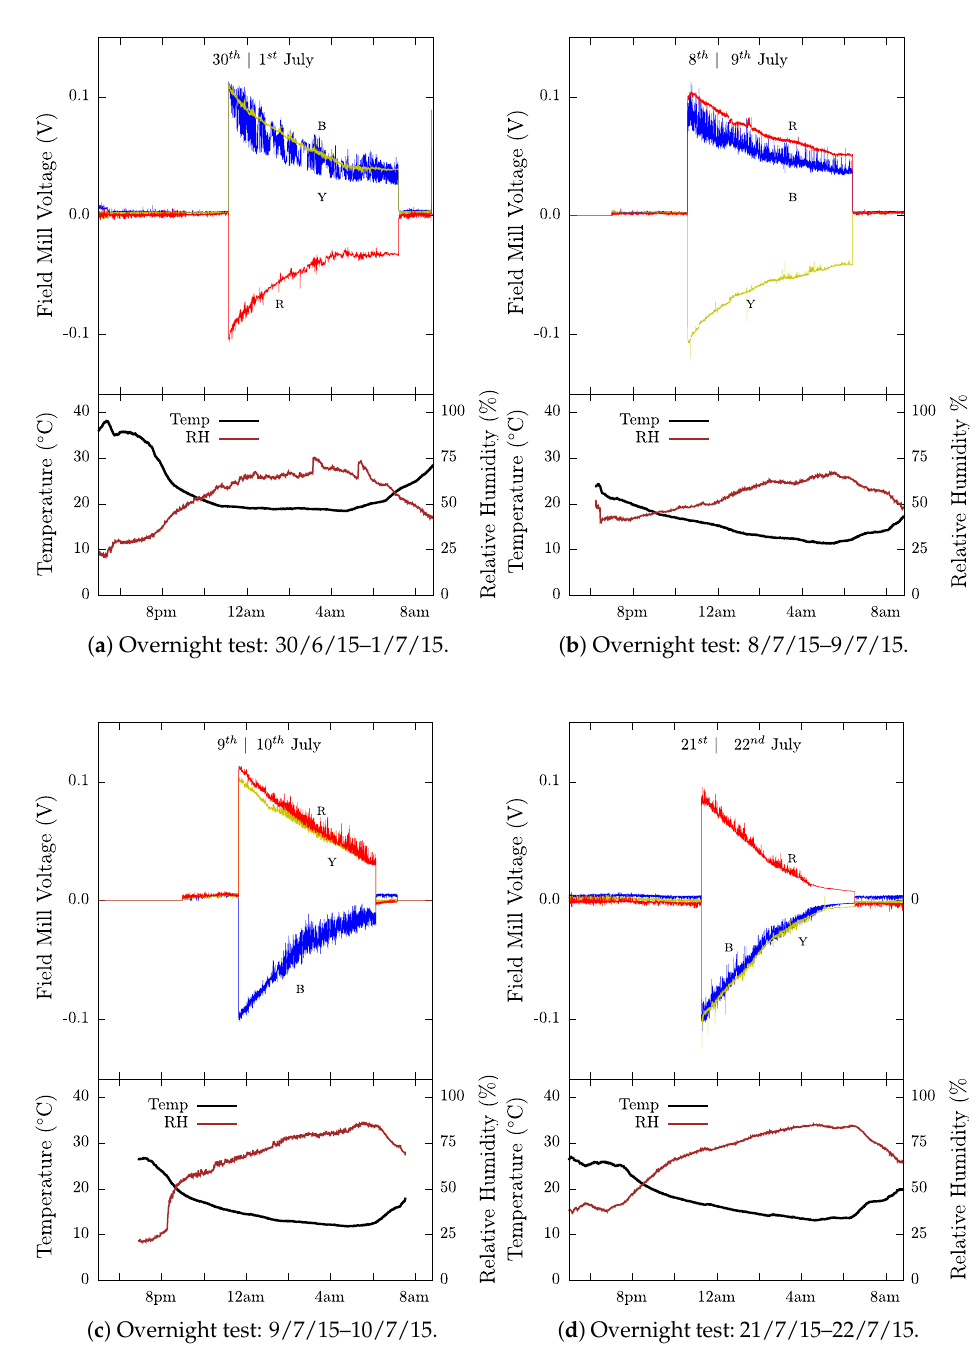
Figure 7. Recorded Field Mill voltages for each phase (R = Red, Y = Yellow, B = Blue) and RH/temperature plotted on the same time